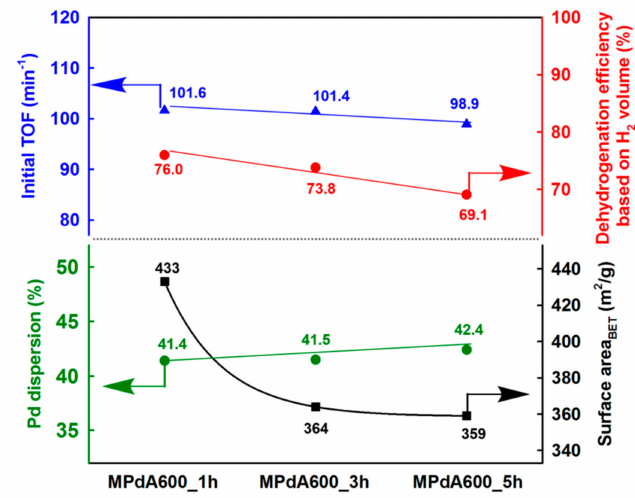
Figure 10. Correlation of the Pd dispersion and BET surface area with the initial TOF and the final dehydrogenation e ffi ciency calculated from the time-dependent H 2 release curves of MPdA catalysts calcined at 600 ◦ C for di ff erent calcination